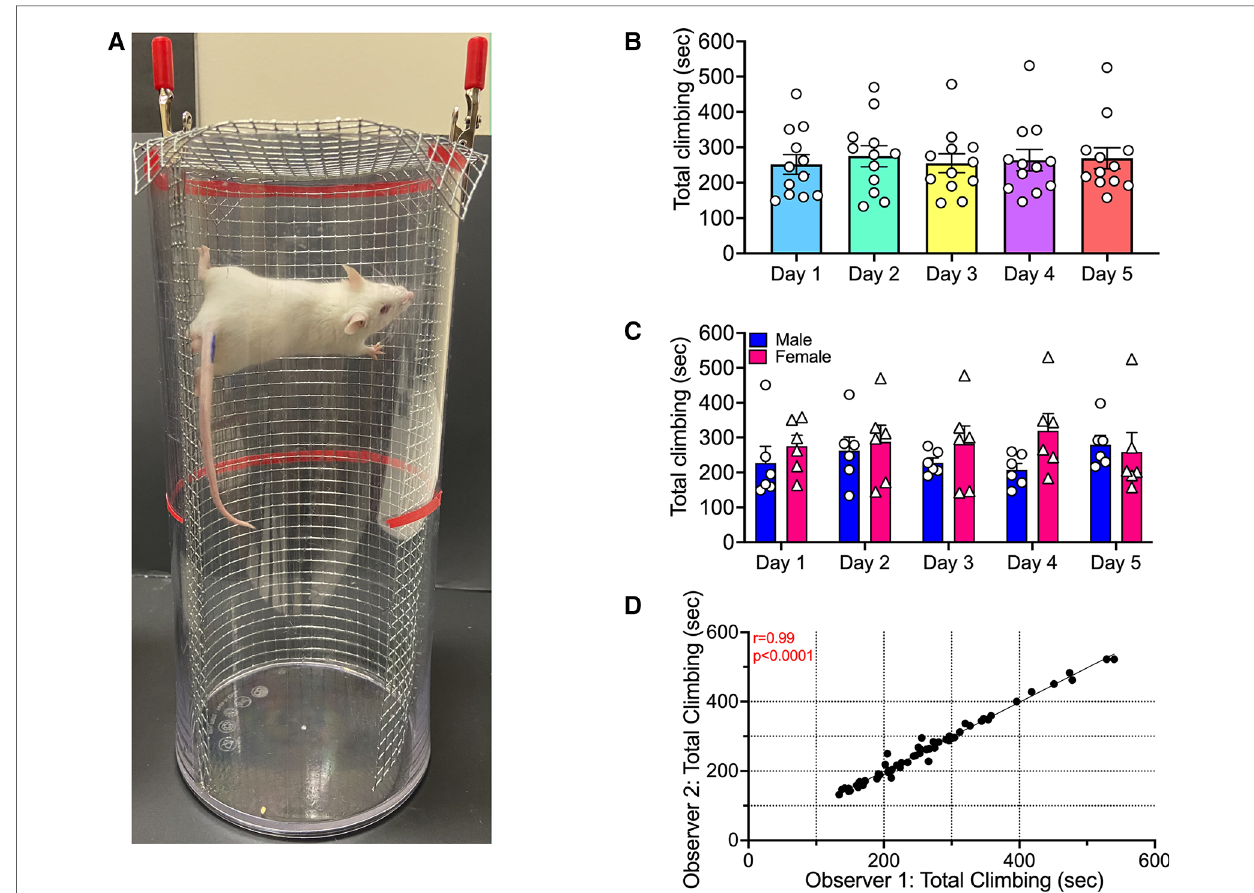
FIGURE 1 Climbing by mice during repeated testing. ( A ) The climbing apparatus. ( B ) Abscissa: Test day. Ordinate: Time climbing in sec. Each bar shows mean±SEM from 12 mice (6 male, 6 female), and points show data for individual mice. ( C ) Same data as in panel B segregated by sex. ( D ) Inter-rater reliability of climbing times assigned by two different observers for all mice across all test